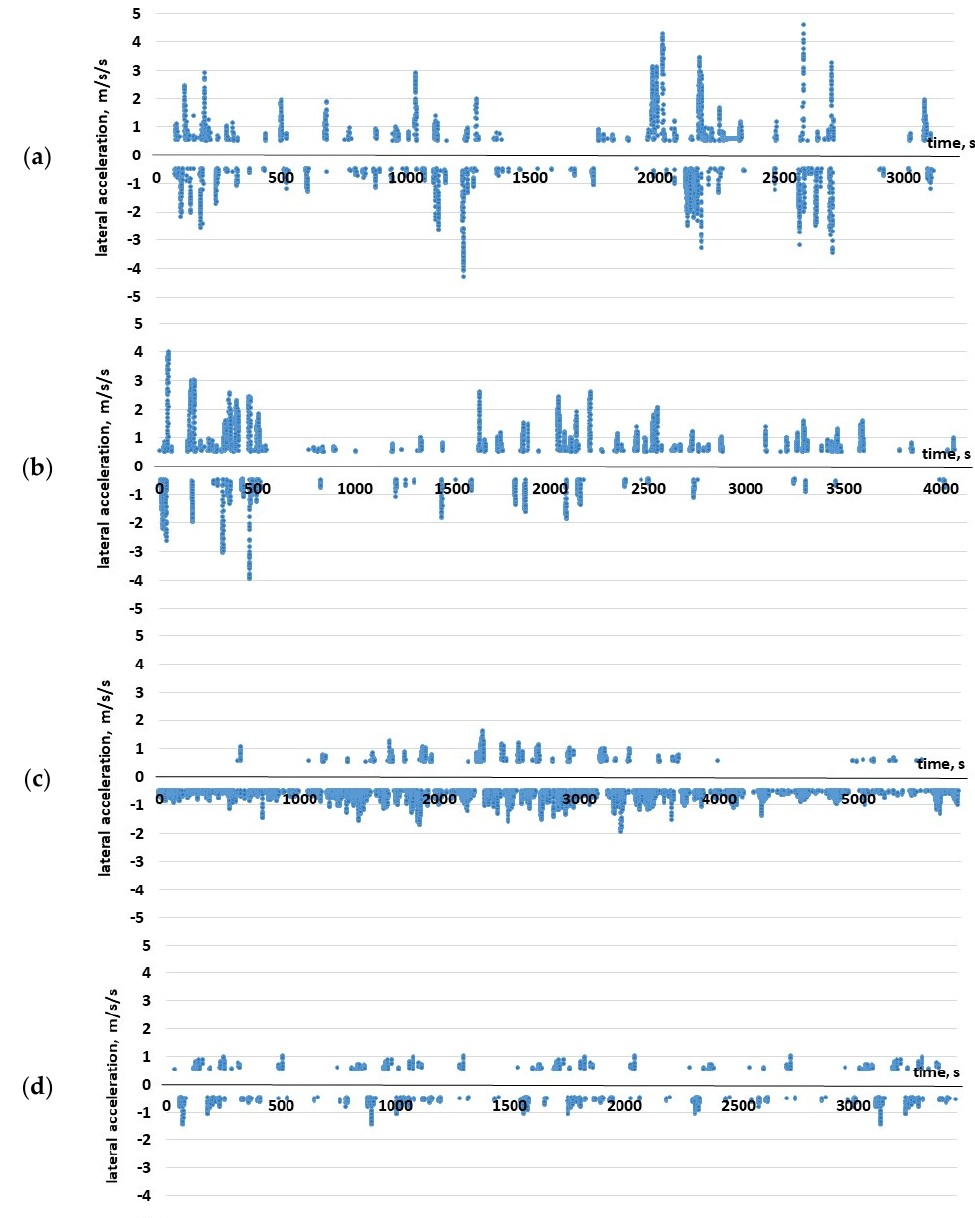
Figure 8. Longitudinal acceleration values excluding the ‘constant speed’ driving range on various road types: ( a ) urban area (city); ( b ) non-urban area (single roadway with two traffic lanes); ( c ) two-roadway expressway; ( d ) motorway.